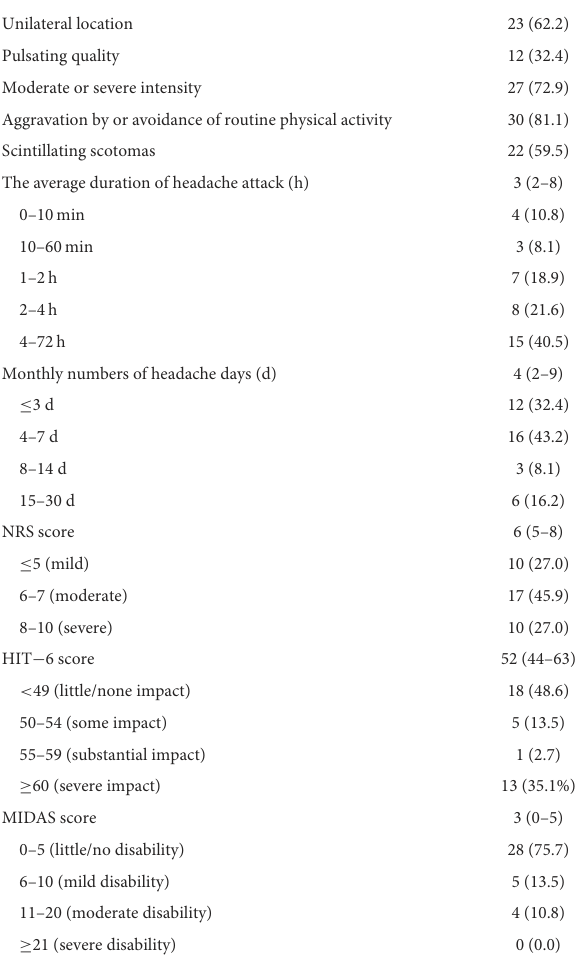
TABLE 4 Detailed clinical characteristics in patients with headaches. Figure 4 indicates the changes in headache parameters according to the management of headaches [conservative therapy (Con; n = 5), cytoreductive therapy alone (Cyt; n